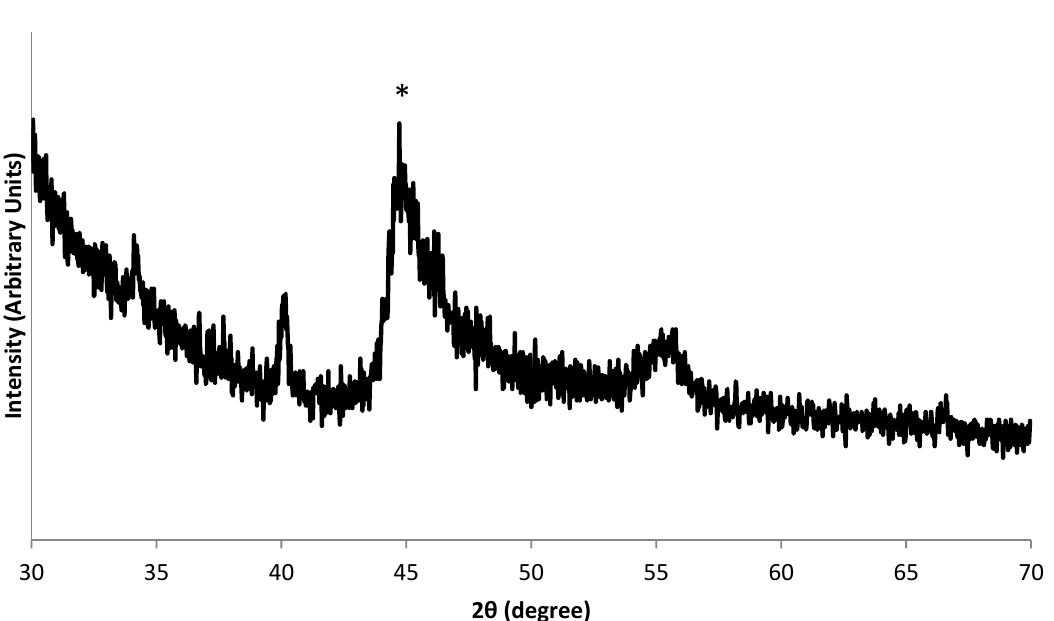
Figure 5. XRD patterns of the AgNPN supported over carbon. * The peak at 44.7 ◦ is characteristic of the (200) plane of FCC silver.